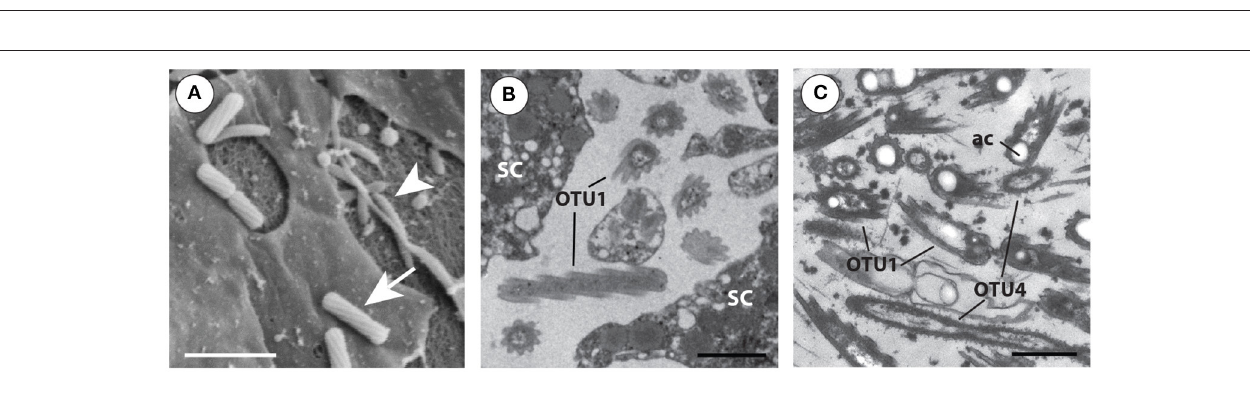
FIGURE 5 | Electron microscopy (EM) images of the two bacterial symbionts that are numerically the most dominant through all Amphimedon queenslandica life stages. (A) Scanning EM of adult tissue showing OTU 1 (arrow) and putative OTU 4 (arrowhead) morphotypes. Scale bar 1 µ m. (B)